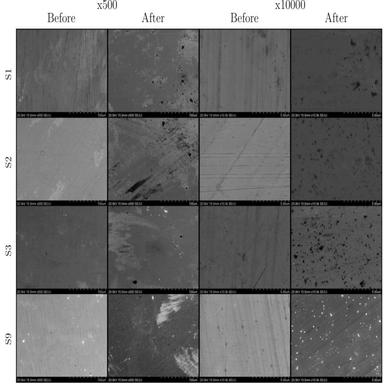
SEM images of the Inconel 625 before and after testing.